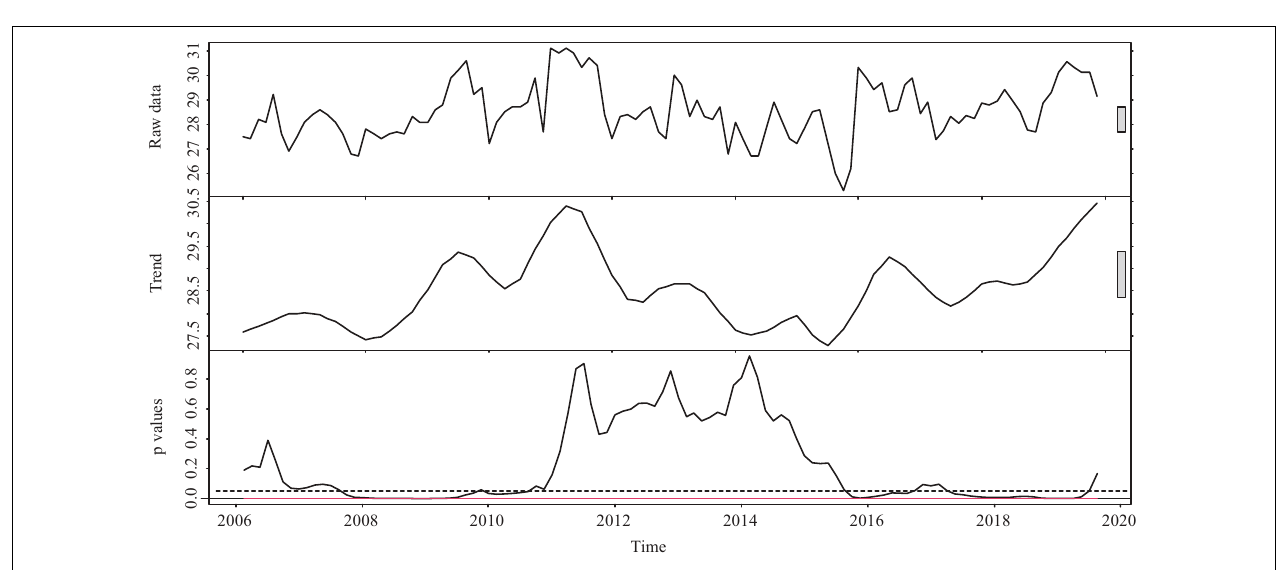
FIGURE 5 | The temperature (two components: raw data and trend) and corresponding p -value from August to September during 2006–2019 in the Pearl River (China). The gray boxes represent the relative magnitude of variation in each component. The trend component is derived by locally weighted scatterplot smoothing. The red line represents the corresponding p -value of the boundary of the F statistics at the confidence level of 99%. The dotted line shows where the p -value equals 0.05.